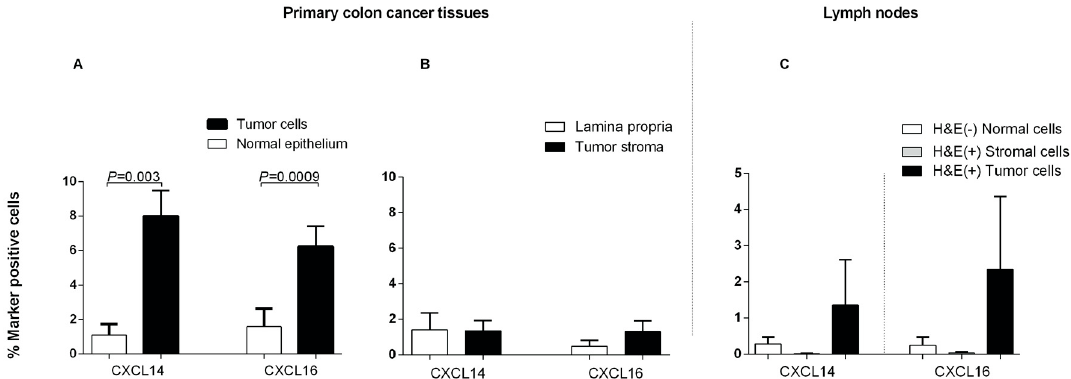
Figure 8. Frequencies of CXCL14 and CXCL16 positive stained cells in primary colon cancer tissue (CC) compared to normal colon tissue and in H&E( + ) and H&E(-) lymph nodes from CC patients as determined by immunomorphometric analysis according to Weibel (1979). ( A ) CC tumor cells (black bars) compared with normal epithelial cells (open bars). ( B ) CC tumor stroma (black bars) compared with lamina propria in normal colon (open bars). ( C ) Metastatic tumors cells (black bars) and other cells of H&E( + ) lymph nodes (grey bars) compared to cells of H&E( − ) lymph nodes (open bars). Bars represent mean + 1 SEM. P -values for comparison between tumor and normal tissue by two-sided